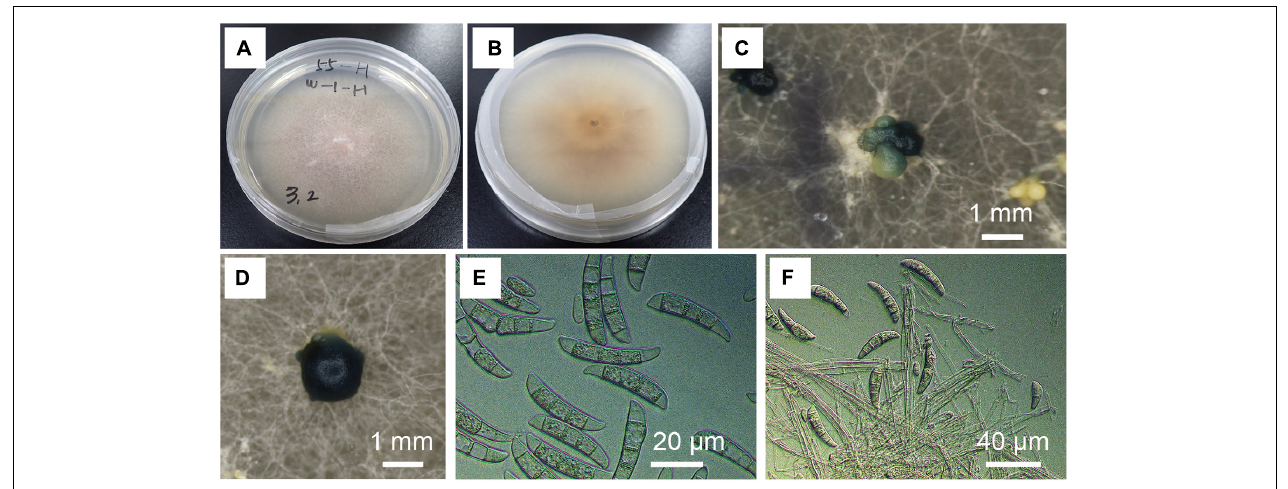
FIGURE 2 | Morphological characteristics of Fusarium kuroshium . (A,B) Colony on potato dextrose agar (PDA) at 25 ◦ C 10 days after inoculation. (C,D) Greenish conidial masses formed on sporodochia in culture on PDA (25 ◦ C, dark, 2 months). (E) Conidial spores in the colony on PDA (25 ◦ C, dark, 2 months). (F) Conidial spores in the colony on synthetic low-nutrient agar (25 ◦ C, dark, 1